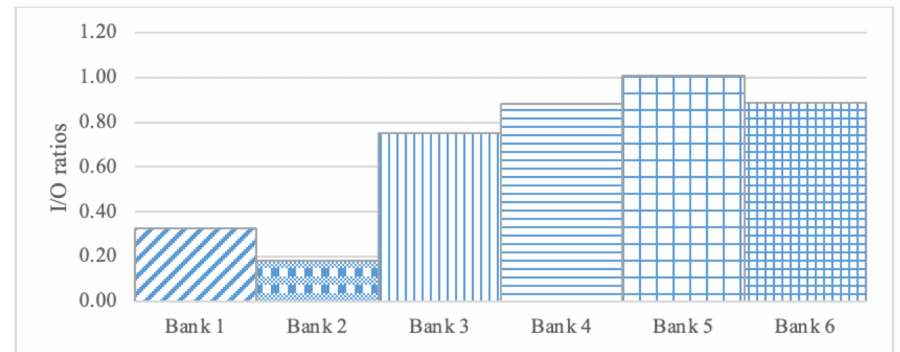
Figure 5. Indoor/Outdoor (I/O) ratio value for PM10 at six different bank offices.